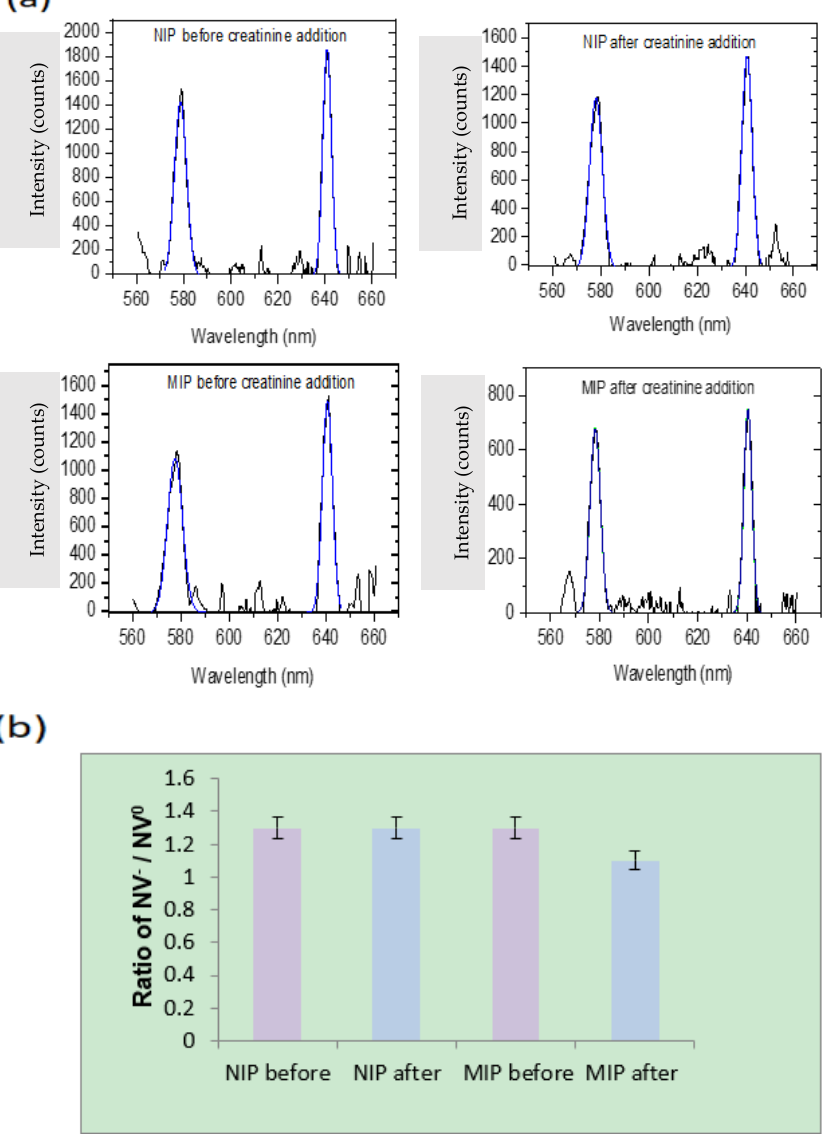
Figure 10. ( a ) Photoluminescence peak fits in the range of nitrogen-vacancy centers after background subtraction and using a Gaussian fitting profile for non-imprinted and molecularly imprinted polymer (before and after creatinine addition). ( b ) Nanodiamond nitrogen-vacancy center intensity ratios (NV − / NV 0 ) before and after the addition of creatinine for non-imprinted and molecularly imprinted polymers. Error bars indicate standard deviation, n = 9 for both polymers.